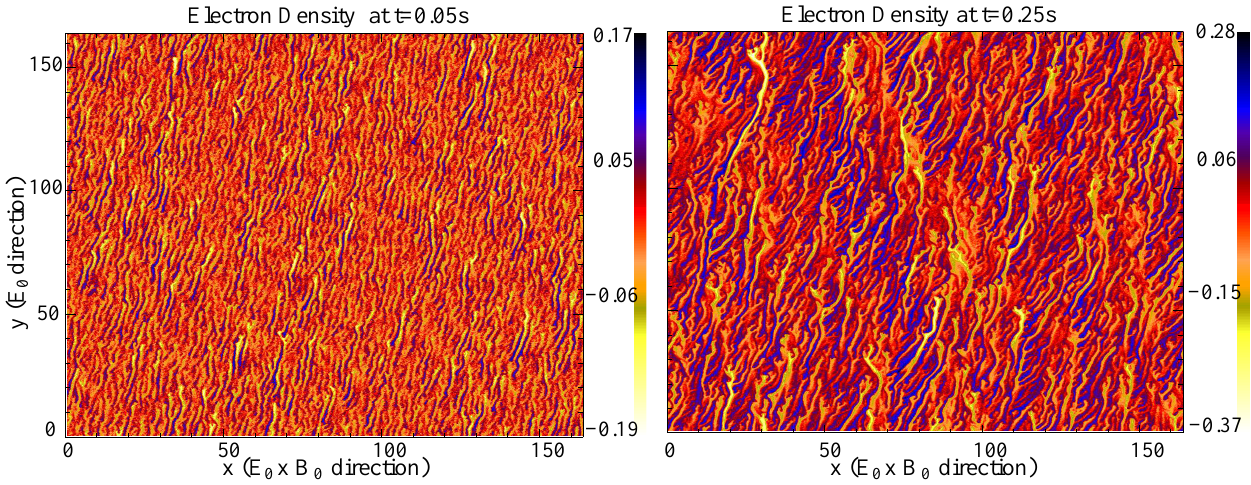
Fig. 1. Plasma density as a function of position at two different times. The color bar to the right indicates the ion density perturbation amplitude. Note that the maximum values of the density perturbation, δn i reflect approximately four times the RMS value of δn i because of statistical variations on large meshes.